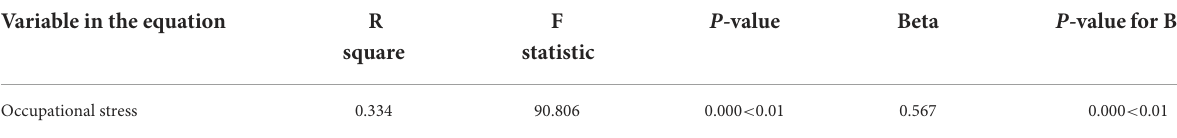
TABLE 17 Regression analysis to explore the influence of occupational stress on health risk (Regression analysis). Variable in the equation R